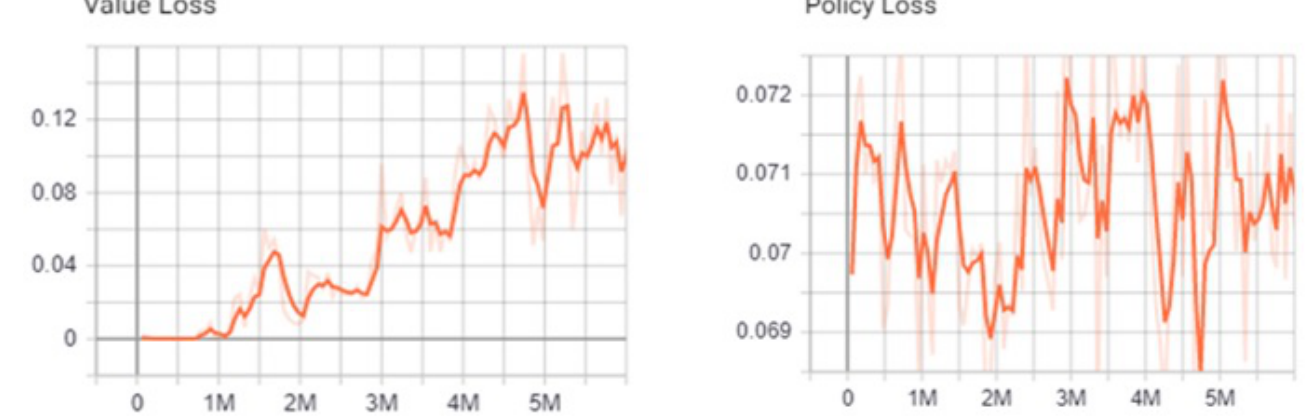
Figure 6. Evolution of losses during the training (Scenario